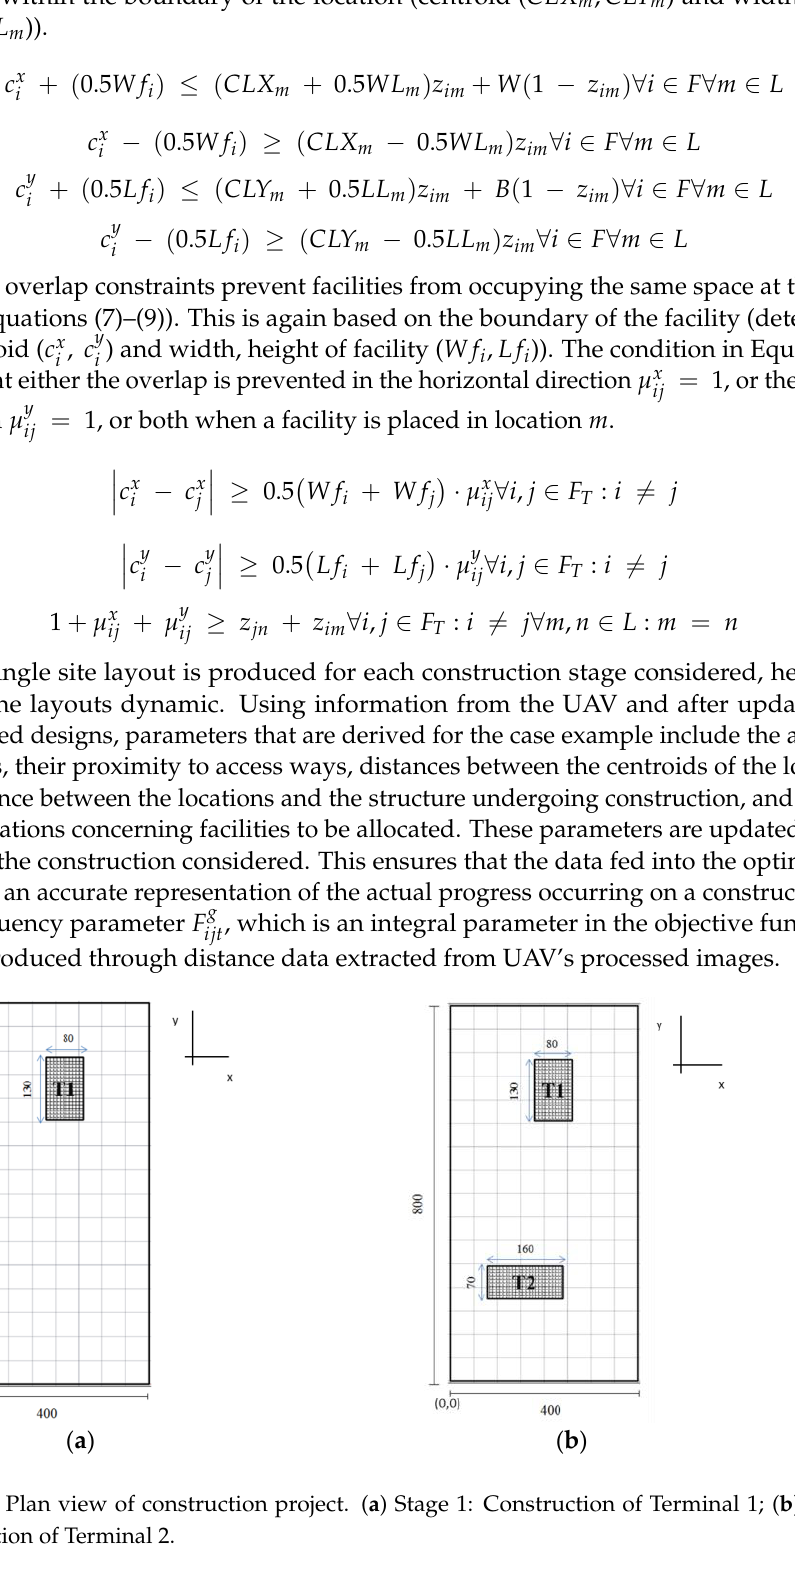
Table 2. Site layout for two stages of the construction process.